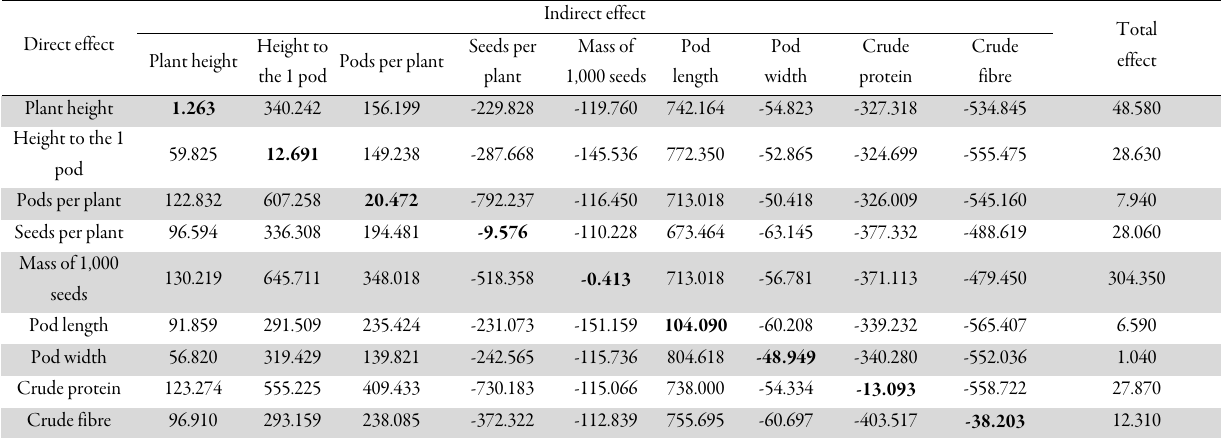
Table 6. Path-coefficient analysis of seed productivity in white lupine